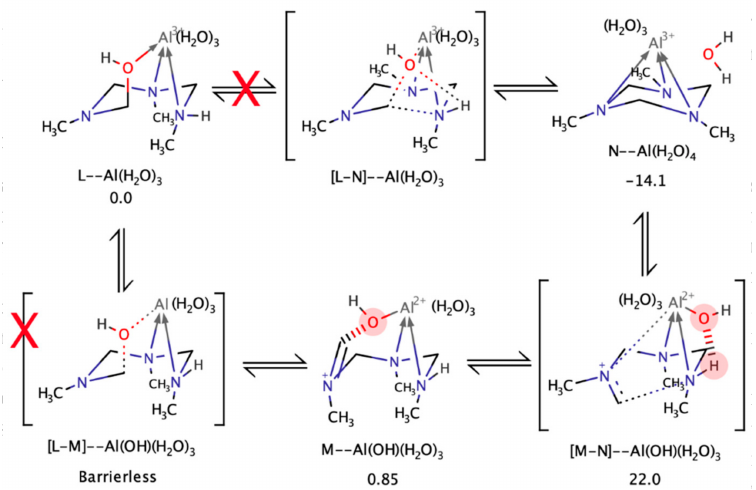
Scheme 6. Ring closure mechanism in the presence of aluminium. The red cross on the bracket for [L-M]—Al(OH)(H 2 O) 3 indicates that the structure is not a stationary